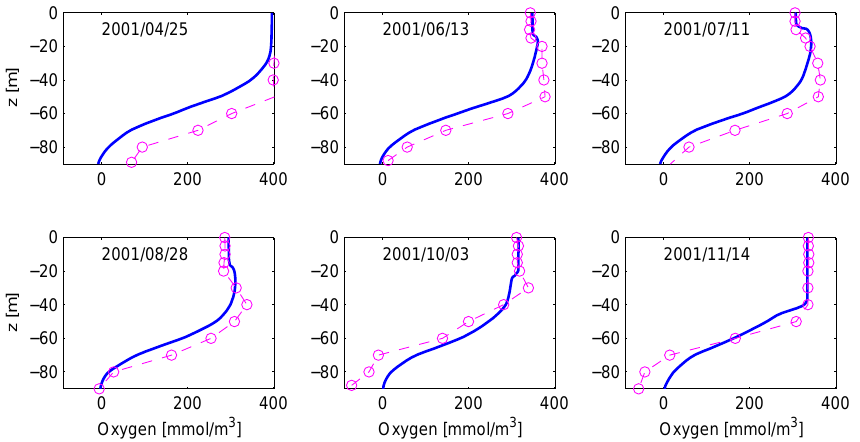
Fig. 7. Vertical oxygen profiles at BS in some selected days of 2001. Calculated results are presented with a solid line, while circles connected with a dashed line show the observation data of BED.